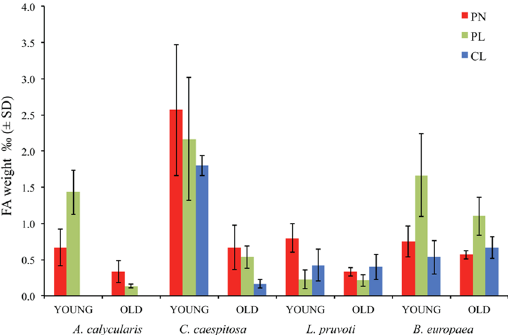
Figure 2. Intra-skeletal fatty acid concentrations. Concentration of intra-skeletal fatty acids in young and old A . calycularis , C . caespitosa , L . pruvoti and B . europaea skeletons collected along a latitudinal gradient of temperature in the Tyrrhenian Sea at Pantelleria island (PN), Palinuro (PL) and Calafuria (CL). A . calycularis was not found in CL.